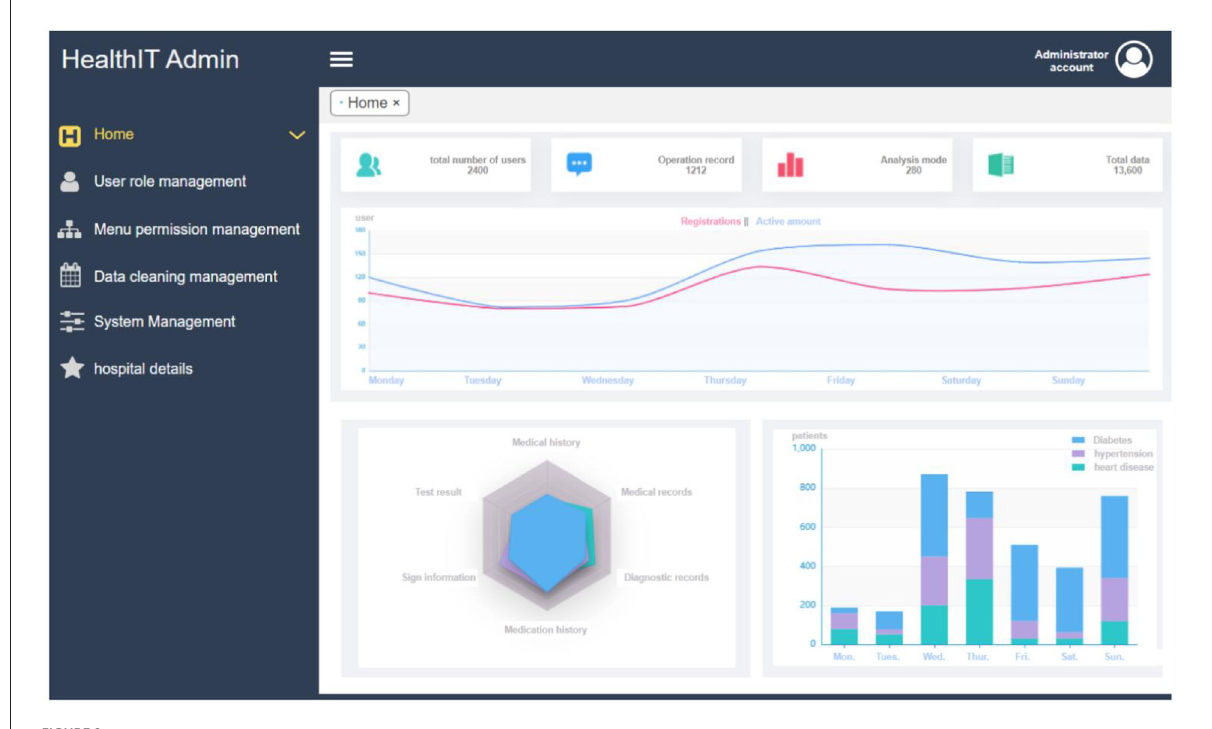
FIGURE9 Data visualization